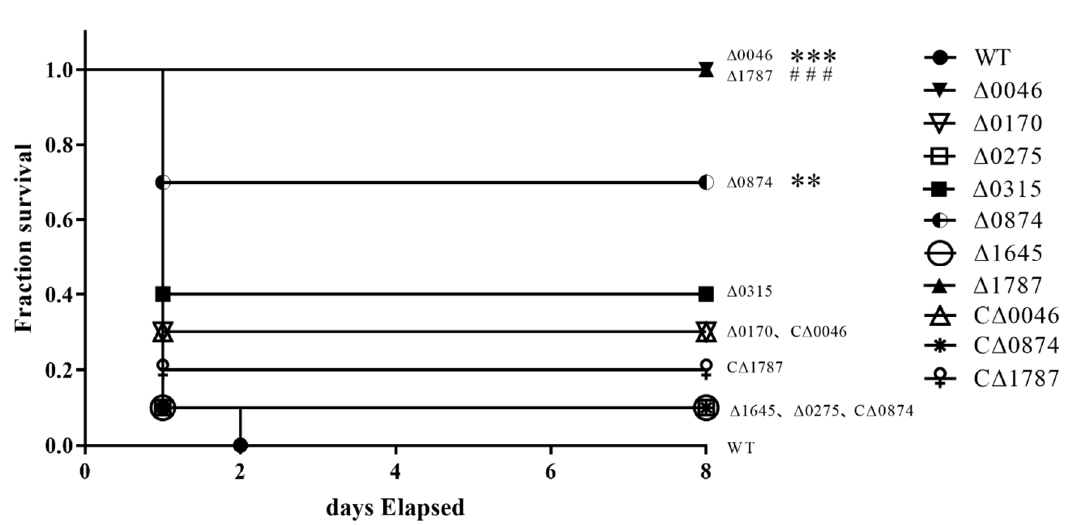
Figure 3. Survival curves of mice infected with SS2 strains. Female C57BL/6 mice in different groups were challenged intraperitoneally with 7 × 10 8 colony-forming units of WT, Δ 0046 , Δ 0170 , Δ 0275 , 0315 , Δ 0874 , Δ 1645 , Δ 1787 , C Δ 0046 , C Δ 0874 or C Δ 1787 strains cultured on tryptic soy agar. The mortality of mice was recorded for 7 days. The results shown are representative of three independent experiments. ** p < 0.01 for Δ 0874 versus WT; *** p < 0.001 for Δ 0046 versus WT; ### p < 0.001 for Δ 1787 versus WT.